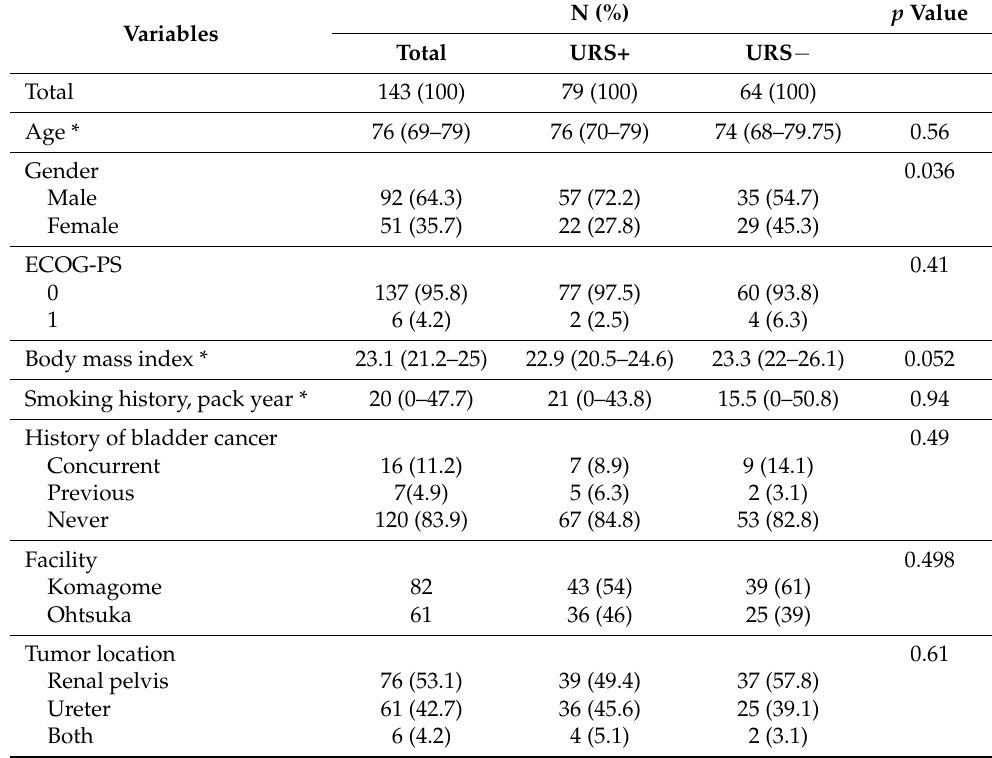
Table 1. Demographics of 143 upper tract urothelial carcinoma patients according to whether or not ureterorenoscopy was performed prior to radical